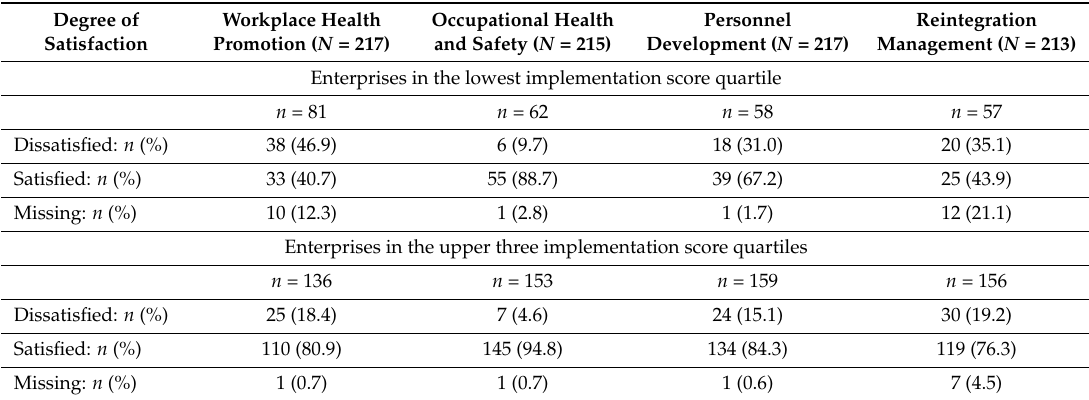
Explication of Table 5: For the sake of clarity, the response categories ‘very dissatisfied’ and ’rather dissatisfied’ were combined to form the ‘dissatisfied’ category, while the response categories ‘very satisfied’ and ‘rather satisfied’ were combined to form the ‘satisfied’